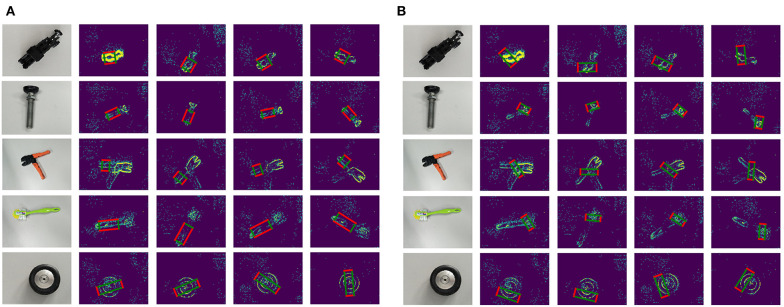
Single-grasping Annotations: (A) Good-grasping parallelogram annotations on original objects' event data; (B) Bad-grasping parallelogram annotations on original objects' event data. There are five typical objects selected, and there are four sampled time points in each recorded moving period. The first column presents the real grasping objects in traditional RGB image; the rest columns present the annotations and original objects' event data. The red edges present the grasping edge; and the green edges present the auxiliary edges.